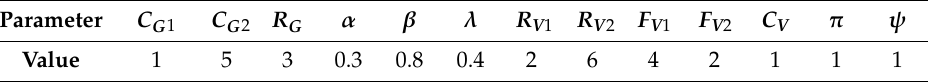
Table 5. Parameter initial value setting.